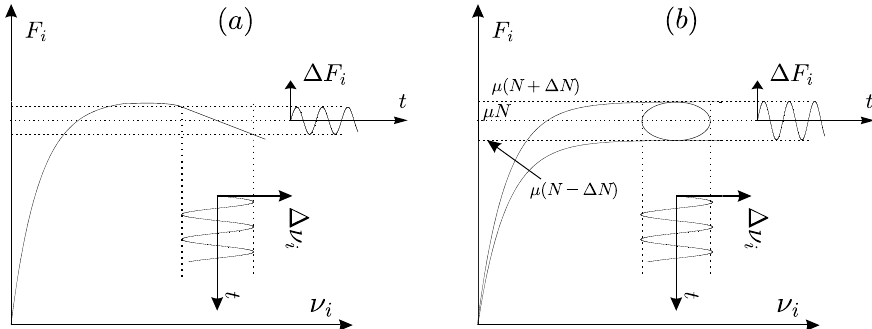
Fig. 1. Friction curves between the wheel and the rail describing two mechanisms for sustained oscillations between the wheel and the rail: (a) Decreasing slope of the friction curve after saturation; (b) Variation of the normal force.